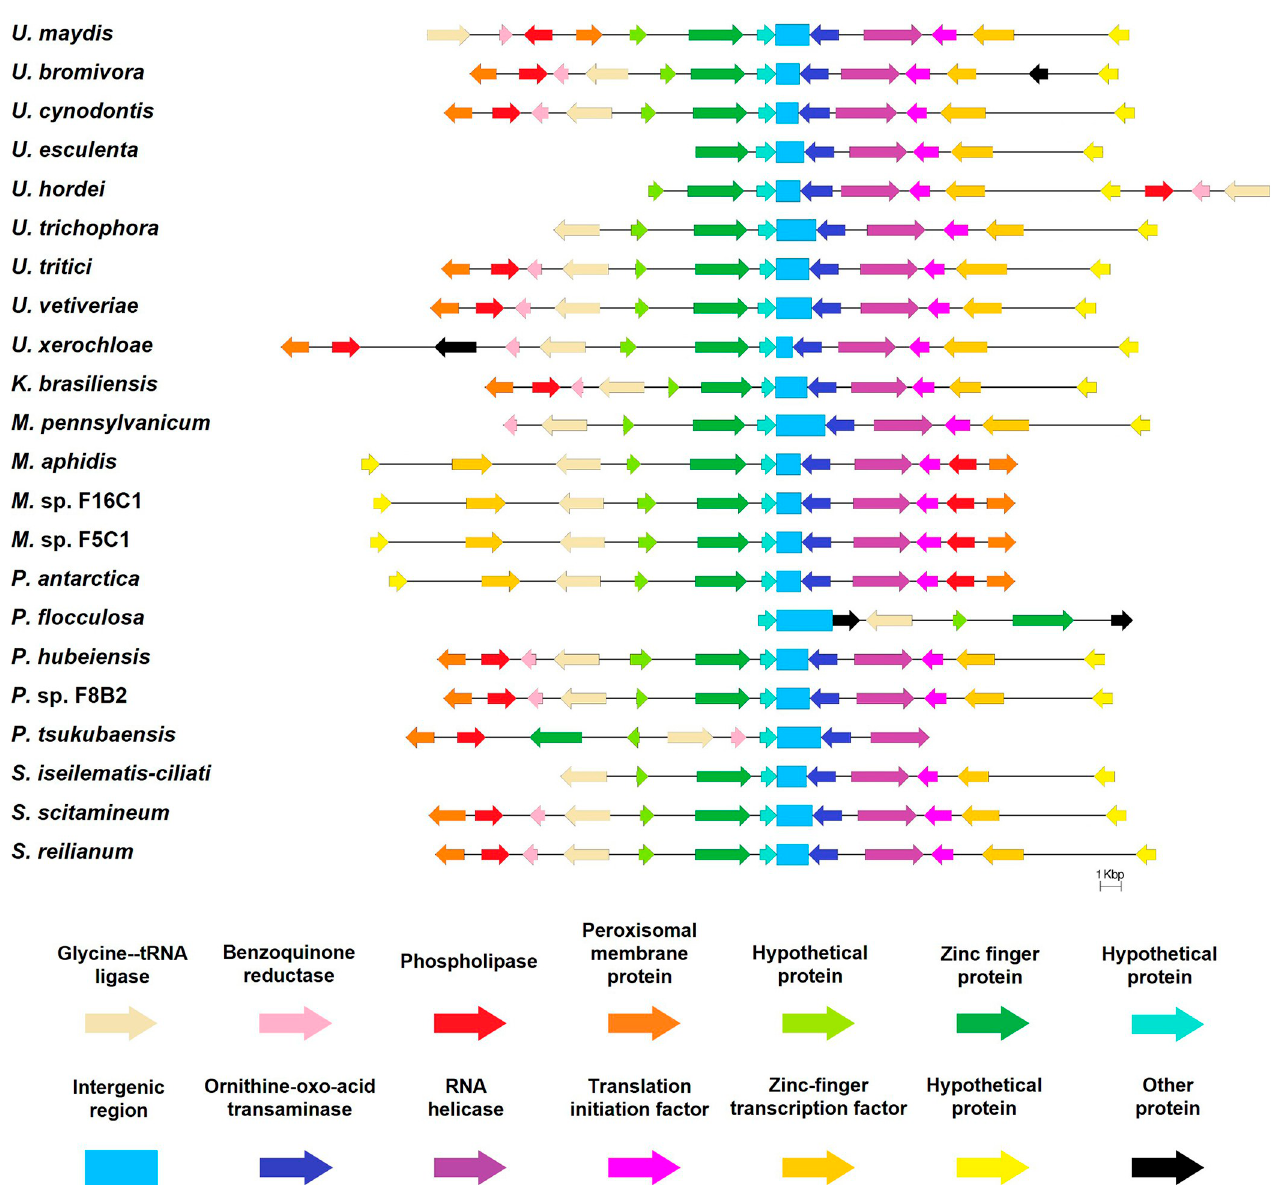
Fig 1. Synteny map around the ter1 locus in Ustilaginales species. Representation of the genes that encode proteins that are located in a widely preserved region around the intergenic area where the ter1 gene is located (indicated by a blue rectangle). The region shows high conservation, where the same two ORFs flank ter1 in every examined organism (except of the 3’ ORF in P . flocculosa